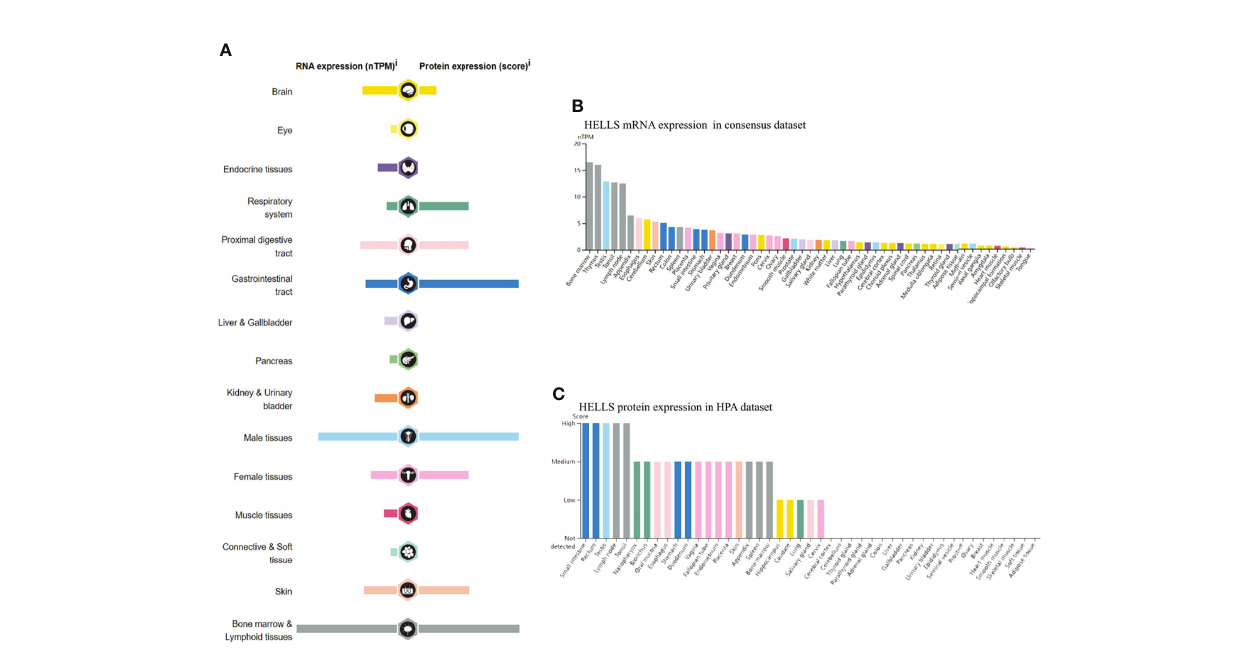
FIGURE 1 | RNA and protein expression pro fi le of HELLS in human organs and tissues. (A) The summary of HELLS mRNA and protein expression in human organs and tissues; (B) HELLS mRNA expression summary in different human organs and tissues based on consensus dataset; (C) HELLS protein expression summary in different human organs and